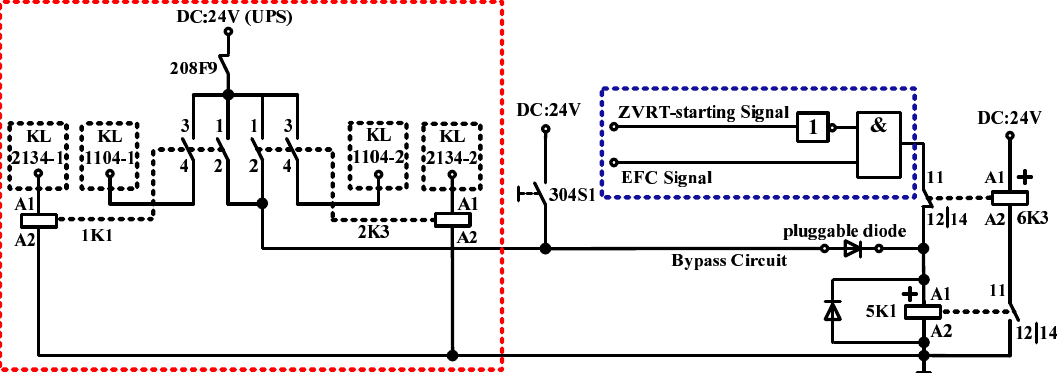
Figure 9. Improved control circuit for